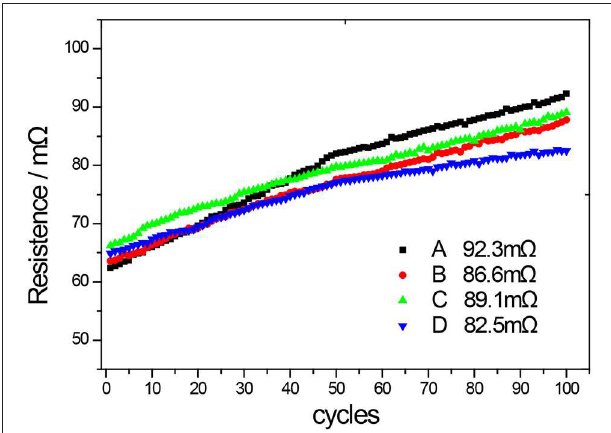
FIGURE 9 | DC resistance data of the coin LIBs consisting of NCM811 and NCM811 coated with different materials during charge/discharge cycling (A-uncoated, B-coated by Al 2 O 3 , C-coated by ZrO 2 , D-coated by